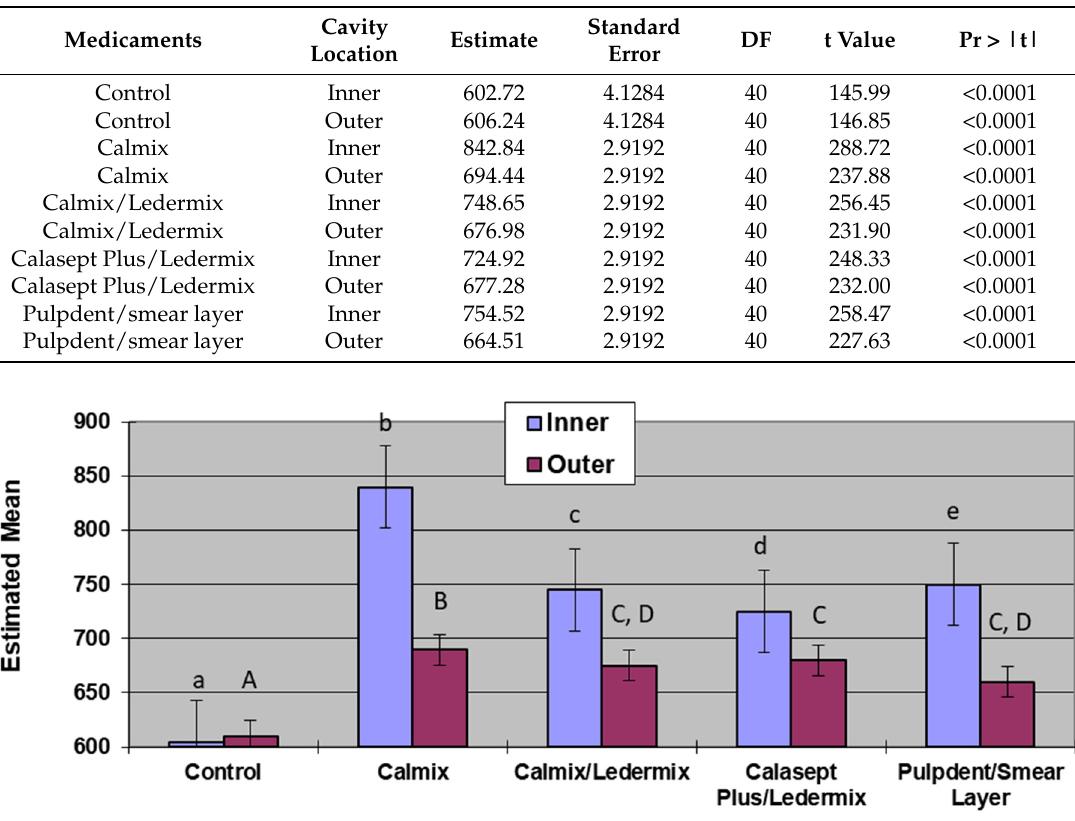
Figure 3. Area under the curve comparisons between groups. Groups with the same letter were not statistically significantly different from each other (lower case for inner dentine; upper case for outer dentine).